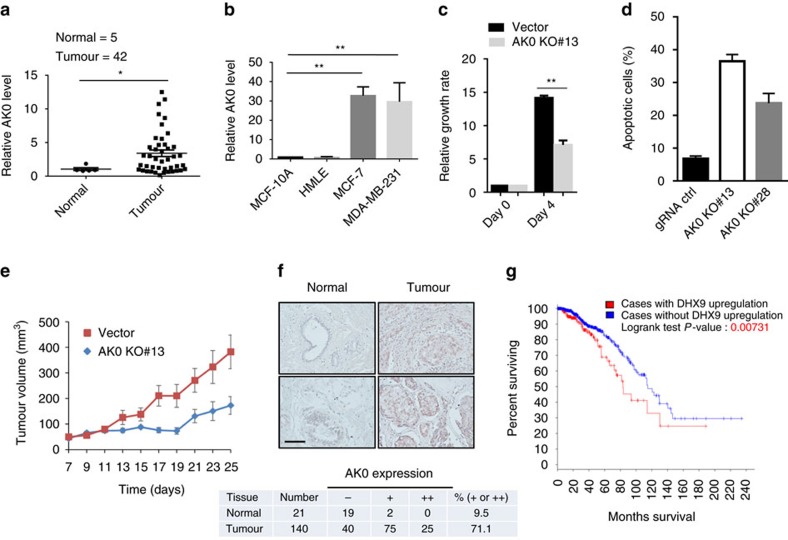
Upregulation of AK023948 in breast cancer and promotion of tumorigenesis.(a) Detection of AK023948 in the OriGene breast cancer tissue cDNA array by qPCR. (b) AK023948 is upregulated in breast cancer cells (MCF-7 and MDA-MB-231) as compared with non-malignant breast cells (MCF-10A and HMLE). (c) AK023948 KO suppresses cell proliferation of MCF-7, as detected by MTT assay. (d) AK023948 KO promotes apoptosis. Cells were seeded in slide chambers, and treated with H2O2 at 0.8 mM for 4 h before TUNEL assay. Apoptotic cells were counted from three different fields, and apoptotic cell ratio was calculated against total cells. (e) Tumour growth for vector control and AK0 KO#13 in nude mice. (f) Expression of AK023948 in breast cancer TMAs, as detected by ISH. Scale bar, 100 μm. Bottom: quantitative analysis of AK023948 expression based on the results from f. (g) Upregulation of DHX9 expression is associated with poor patient survival. About 20.9% (229 of 1091 cases analysed) are positive for DHX9 using the Onco Query Language (OQL; EXP>1.5). Values in b,c are s.e.m. (n=3). **P<0.01 by two-tailed Student's t-test.